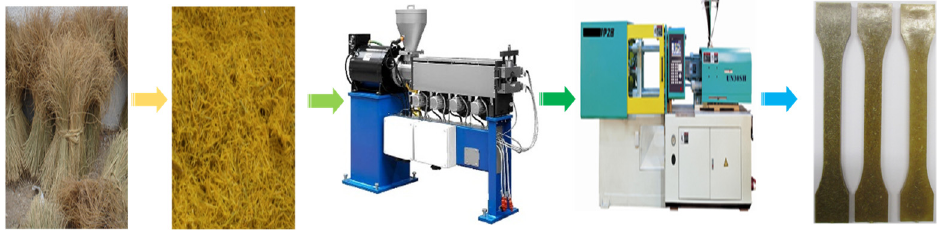
Figure 1. Injection process for PP/alfa specimens.